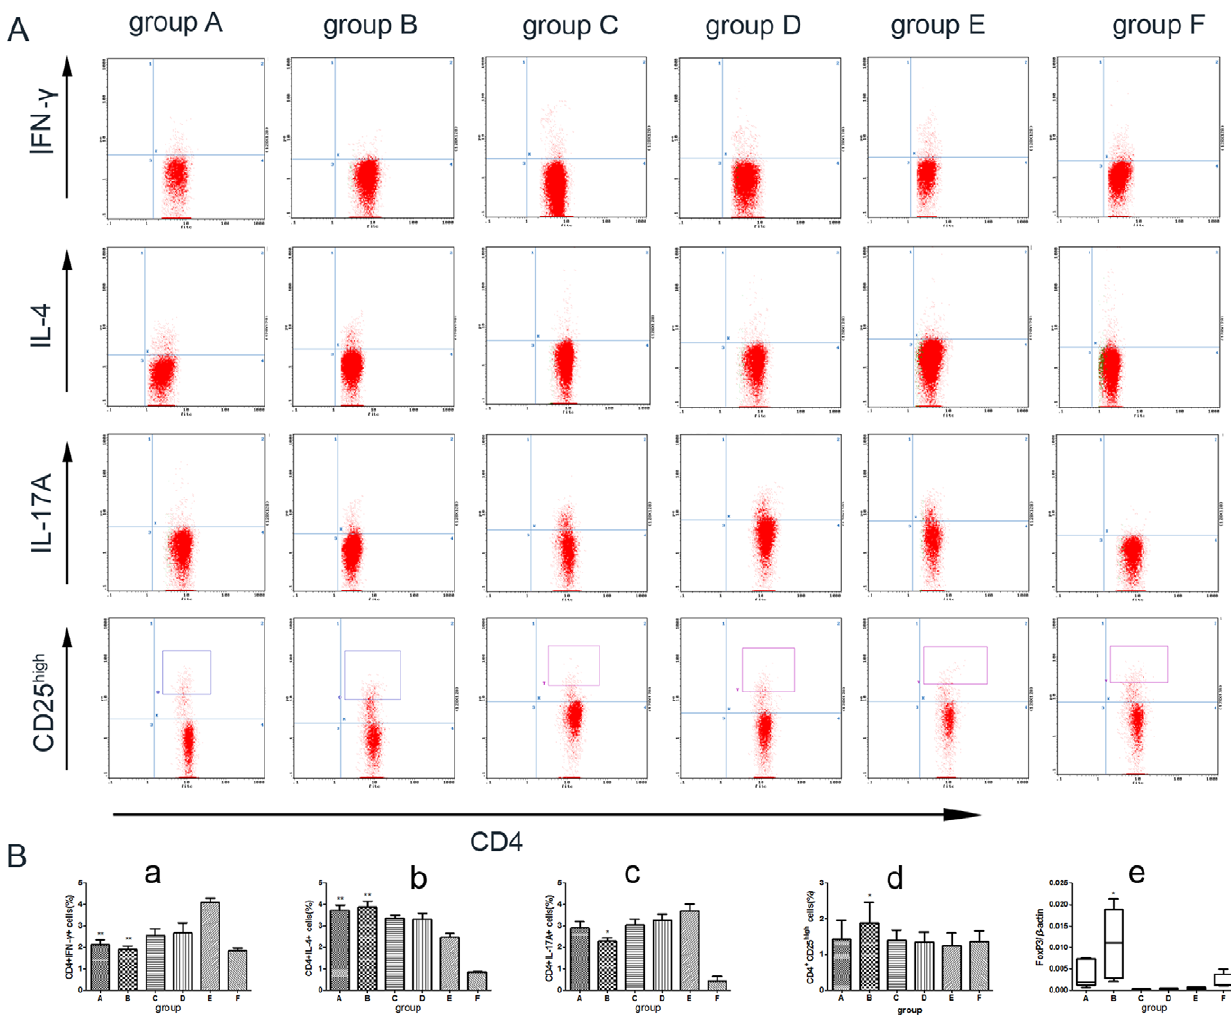
Figure 5. The protective effects of S.japonicum infection were associated with expanding Th2/Treg cell subpopulations. A and B (a, b, c, d), Elevated Th2/Treg cells in prior infection mice. Splenocytes were obtained from DBA/1 mice 12 weeks after CII immunization. Splenocytes were analyzed by FCM for CD4 + CD25 high Tcells, or CD4 + IFN- c + , CD4 + IL-4 + and CD4 + IL-17A + cells after in vitro re-stimulation with PMA/ionomycin in the presence of monesin for 4 hrs (See Materials and Methods for detail). Both unisexual and bisexual infection prior CII immunization enhanced the percentage of CD4 + IL-4 + T cells and reduced the presence CD4 + IFN- c + T cells in the spleen. However, the increase in CD4 + CD25 high Tcells and the decrease in CD4 + IL-17A + T cells were only noted in bisexually-infected mice. B (e), the elevated mRNA expression of Foxp3 was also demonstrated only in prior bisexually-infected mice. Compared with CIA control group, *: P , 0.05; **: P , 0.001. Abbreviations: FCM, flow cytometry; Foxp3, foxhead box protein 3. See Figure 1 for other